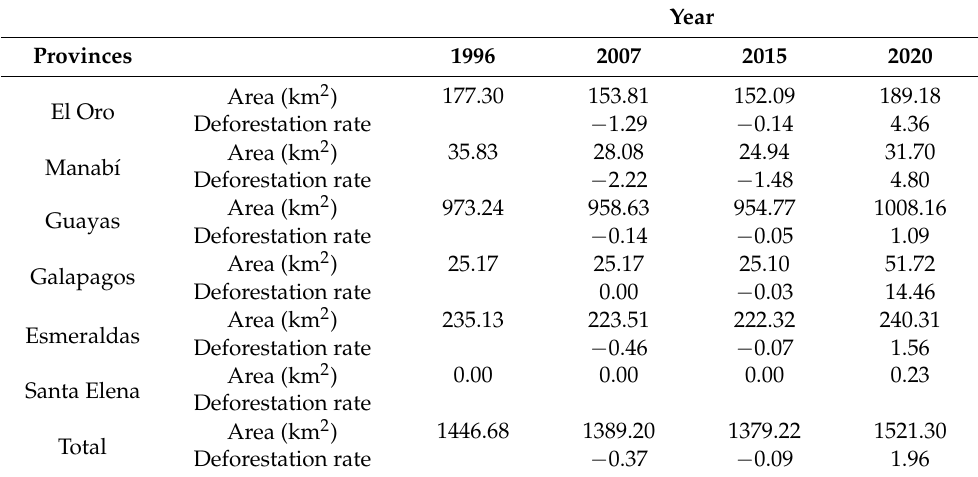
Table 3. Deforestation rate and area per province in the years 1996, 2007, 2015, and